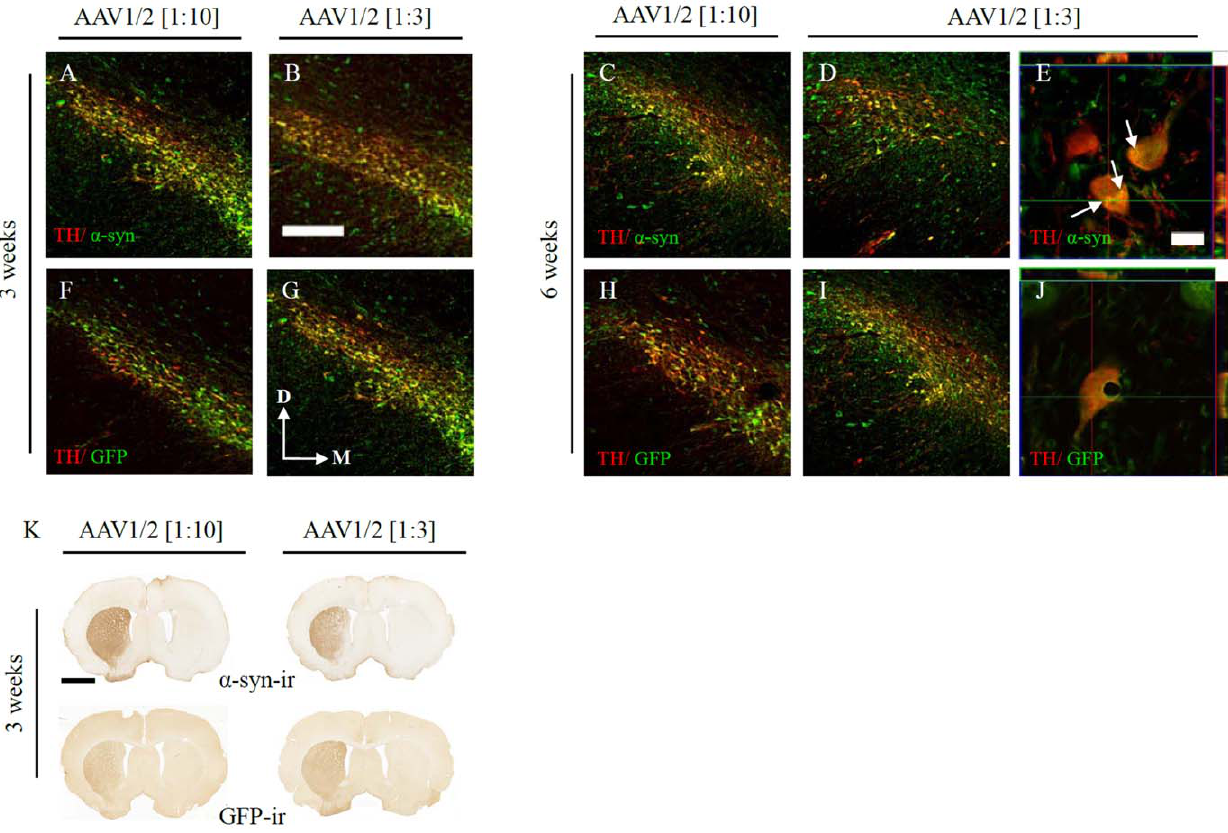
Figure 1. Transgene expression in the substantia nigra and striatum. AAV1/2 delivered to the substantia nigra (SN) as two concentrations (1:3, 1.7 6 10 12 gp/ml and 1:10, 5.1 6 10 11 gp/ml) resulted in expression of human a -synuclein (A–E) or GFP (F–J) in the vast majority SN TH-ir neurons and transport of transgenes to the striatum (K). Confocal imaging and orthogonal views of collected Z-stacks confirmed that a -synuclein accumulated (white arrows in G) within SN TH-ir neurons (G). Scale bar in panel A is 200 m m and applies to panels A–D, F–I. Scale bar in panel G is 20 m m and applies to panels G and J. Scale bar in panel K is 1 mm.